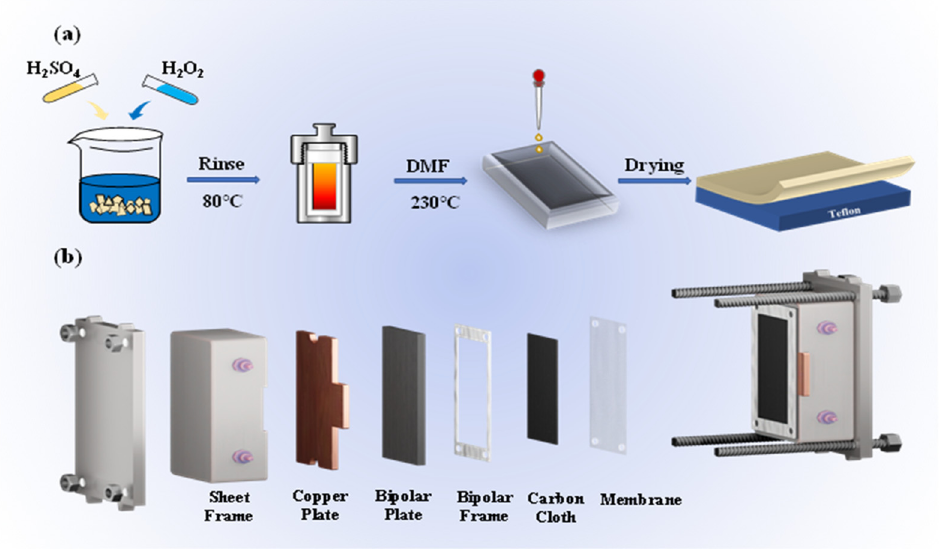
Figure 1. ( a ) Schematic diagram of RM preparation process, ( b ) battery structure schematic.